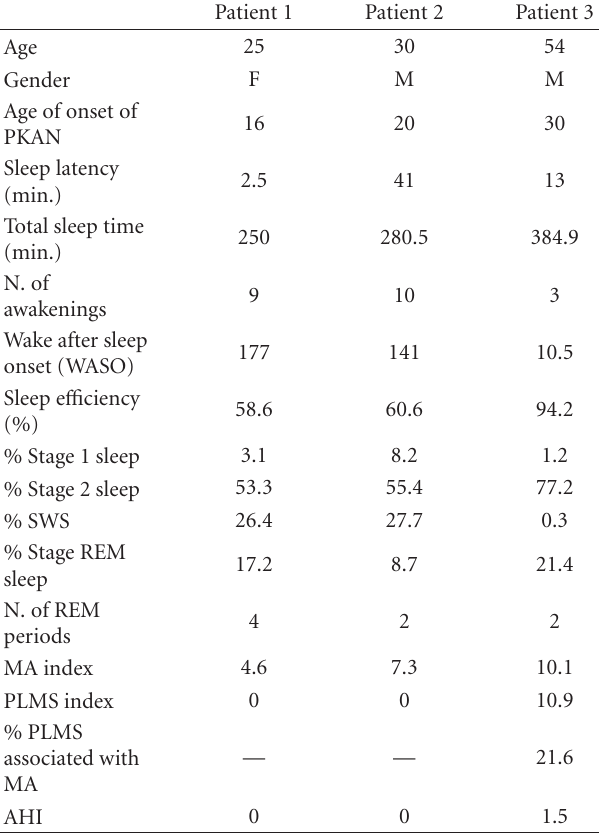
Table 1: Polysomnographic characteristics of patients with PKAN.